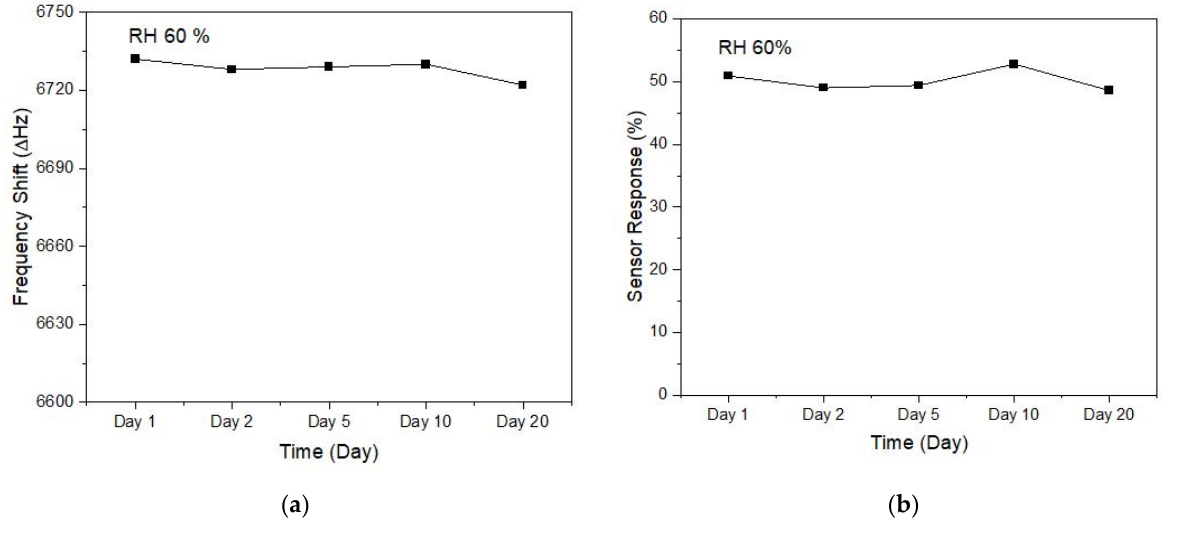
Figure 9. Stability testing of gas sensor ( a ) RGO and ( b ) MOX.